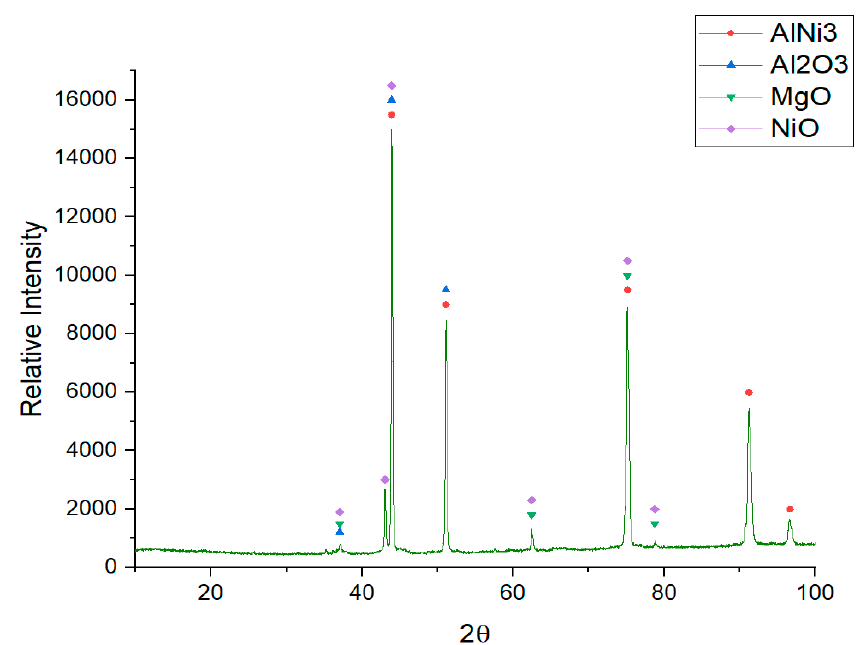
Figure 6. X-ray diffraction (XRD) obtained in HR224 after 50 h of immersion in chloride molten salt at 720 °C.